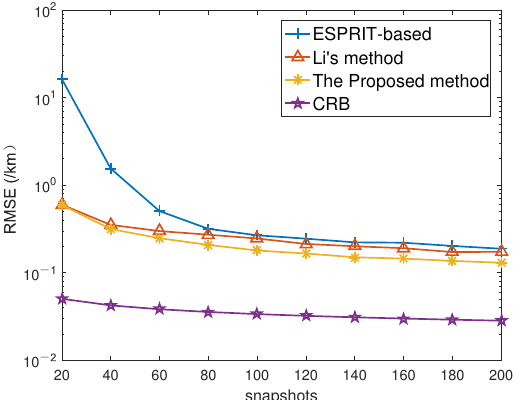
Figure 8. Range estimation RMSE performance versus the number of snapshots, SNR = 20